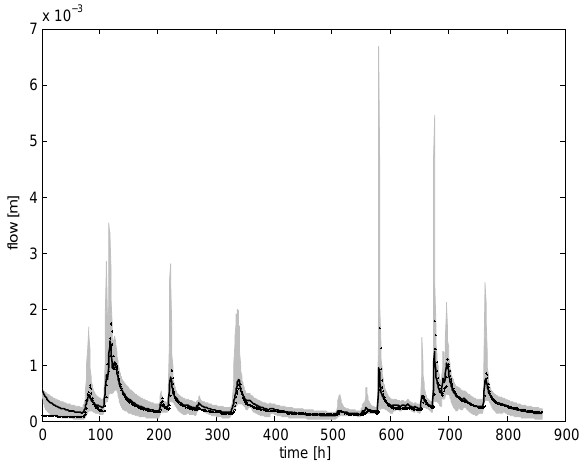
Fig. 4. Validation of the TOPMODEL: 74.7% of output varia- tion explained; dots denote the observations, simulations (posterior mean) are marked by a solid black line, shaded area denotes 95% confidence bands.